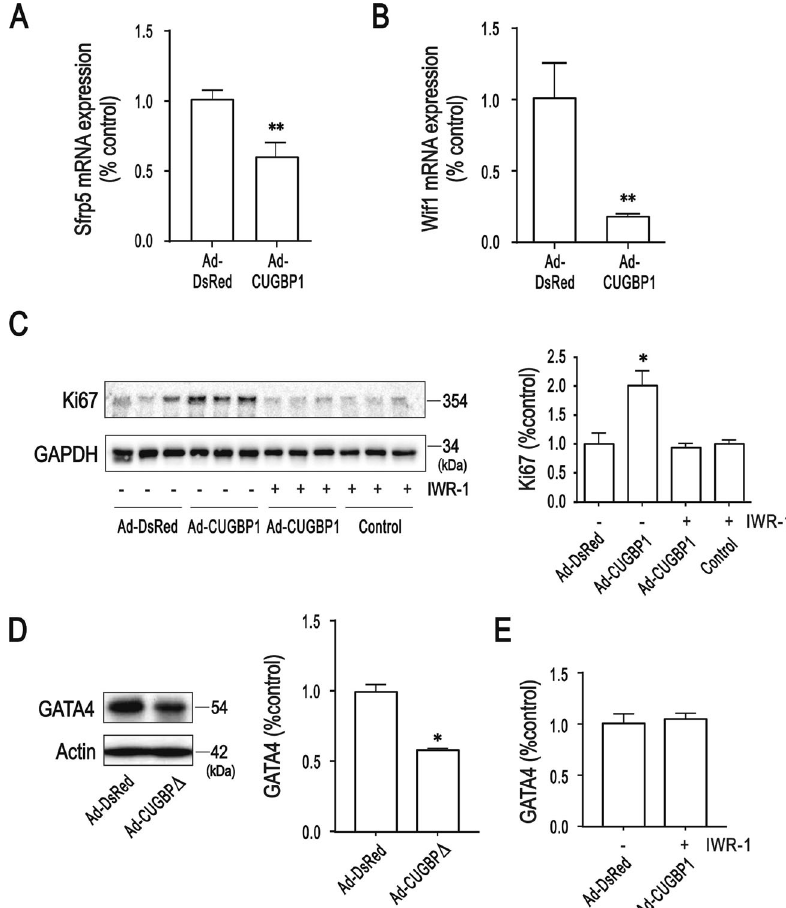
Fig. 4 CUGBP1 mediates cardiomyocyte proliferation through Wnt / β -catenin pathway. A , B Cardiac tissues from 14-day old mice with CUGBP1 over-expression and apical resection were collected at 7 days after the surgery and mRNA expression level of Sfrp5 and Wif1 were determined by real-time quantitative PCR. C Western blotting of ki67 in Ad-virus infected primary cardiomyocyte with IMR treatment. Bands were quanti fi ed by densitometry and normalized to GAPDH. D Statistical analysis of western blot with GATA4 expression upon CUGBP1 inactivation in 1-day old mice heart. E Statistical analysis of western blot with GATA4 abundance upon CUGBP1 over-expression and IWR-1 treatment. Data are the mean ± SEM ( n = 3). * p < 0.05, ** p < 0.01 vs.